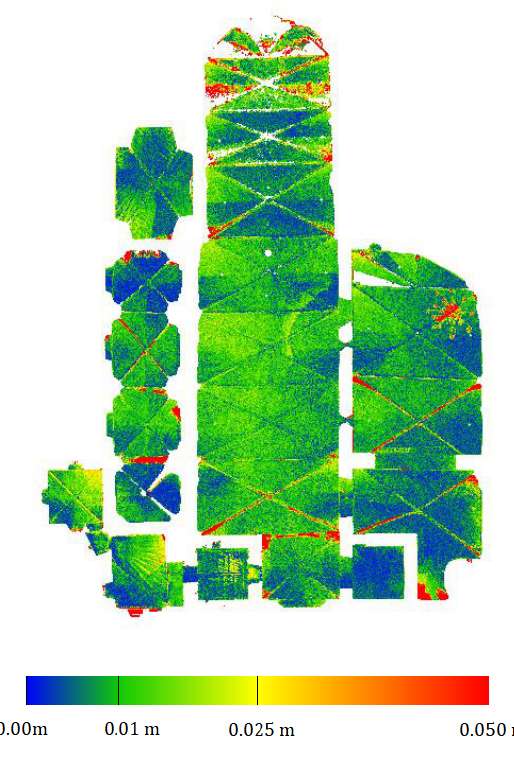
Figure 7 . Cloud-to-cloud comparison of the church between a point cloud from Leica BLK360 and a point cloud from Leica